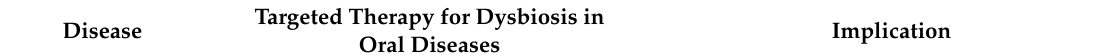
Table 6. Targeted therapy for dysbiosis in oral